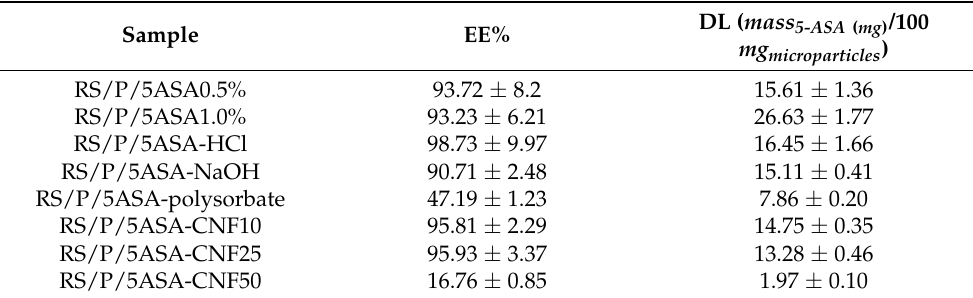
were expressed as average ± standard deviation (n =